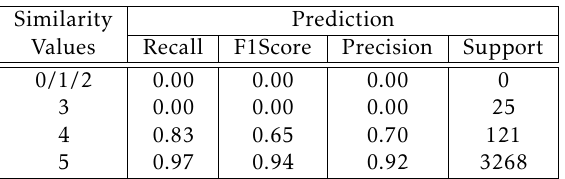
Table 4. Replaceability Test Results based on Convolution Neural Networks Similarity